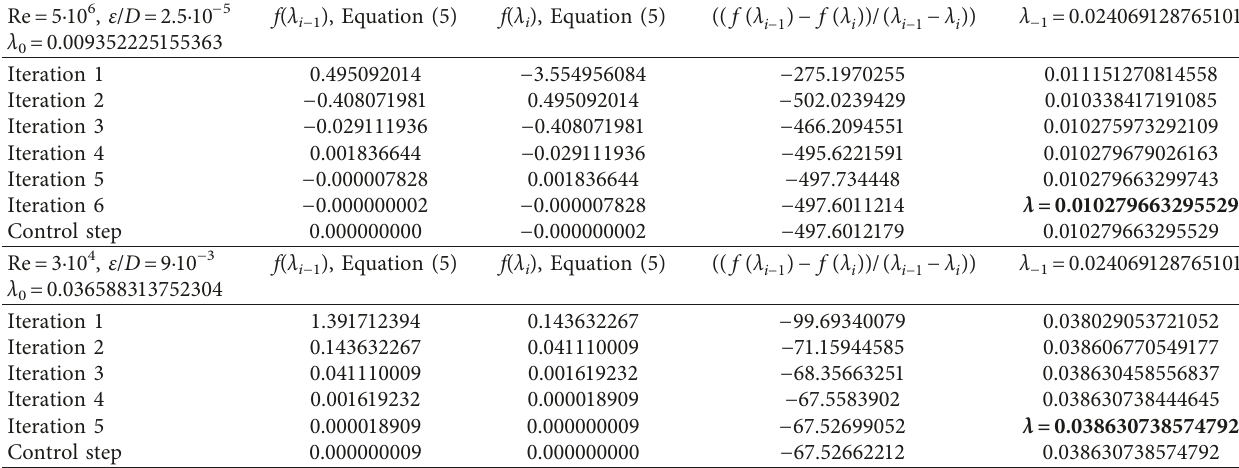
Table 8: Secant procedure. Option 8: two initial starting points λ 0 and λ − 1 required: starting point λ − 1 is with fixed value λ − 1 � 0.024069128765101 (i.e., x − 1 � 6.445695939) as in Section 2.2.1, while starting point λ 0 depends on input parameters: Equation (2), and direct calculation of λ : Equation